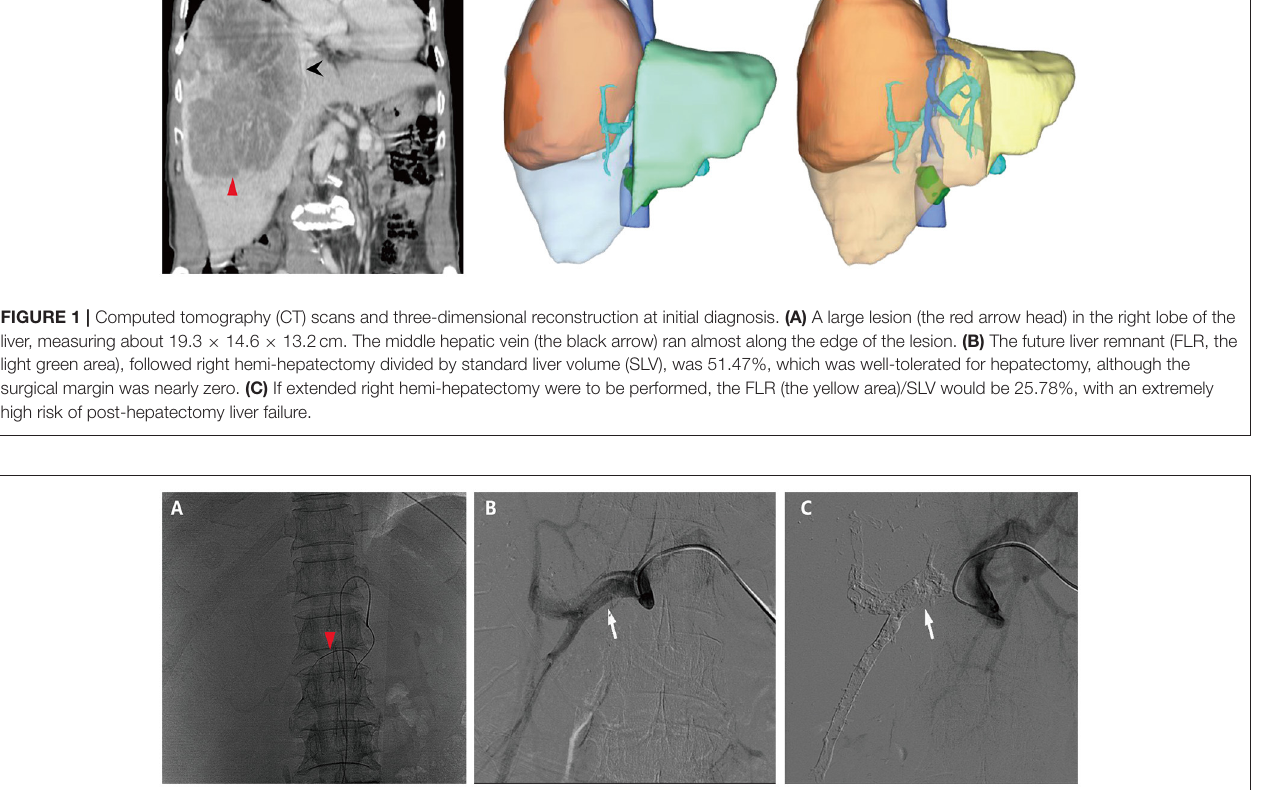
FIGURE 2 | Hepatic artery infusion chemotherapy and portal vein embolization. (A) The tumor was mainly fed by both right and left hepatic arteries, so the infusion microcatheter was selectively placed into the common hepatic artery (the red arrow head). (B) The right branch of the portal vein before embolization (the white arrow). (C) The right branch of the portal vein after embolization (the white arrow).